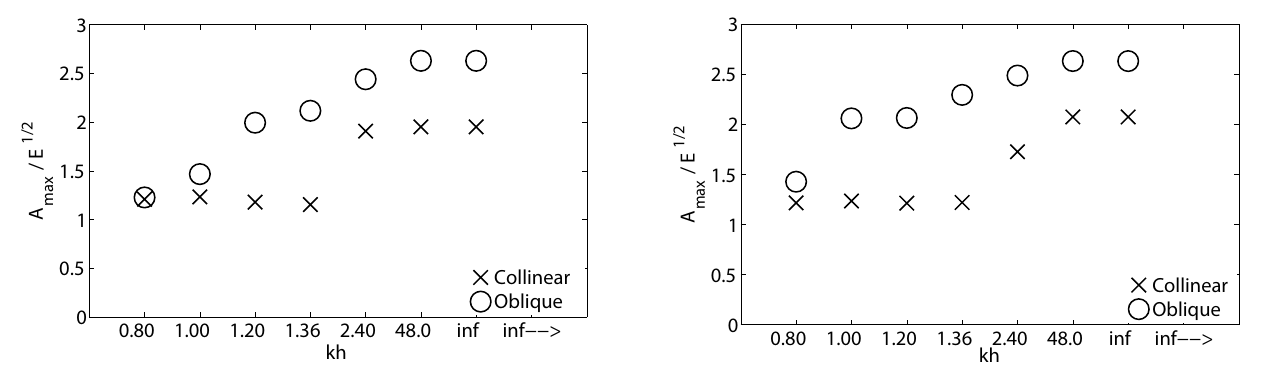
Fig. 5. Maximum wave amplification as a function of the relative water depth for k 0 a 0 = 0 . 12, M = 5.